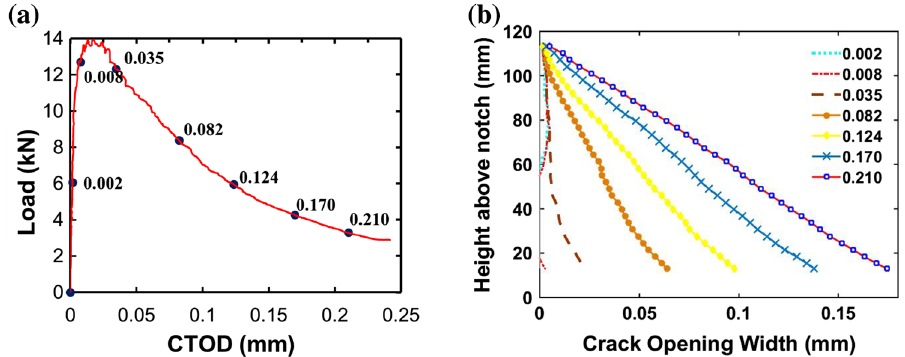
Fig. 8 a Load-CTOD response of a control specimen; b Crack opening width as a function of height above the notch for different values of CTOD.